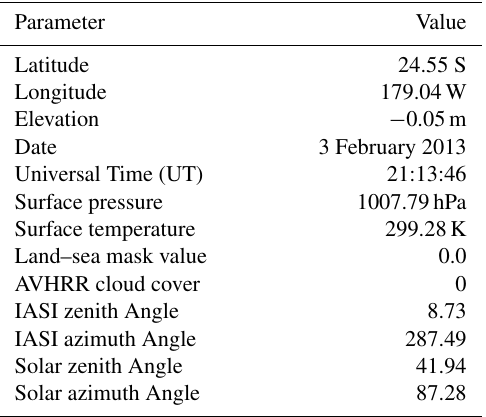
Table 4. Additional parameters associated with the observations shown in Fig.